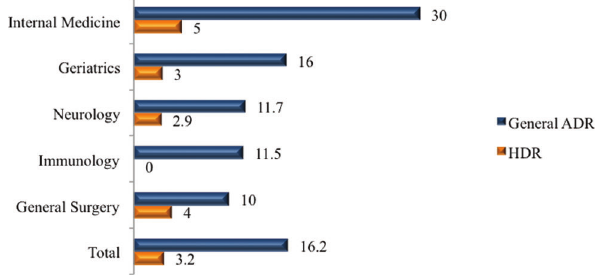
Figure 1 - Incidence of ADRs and HDRs by medical specialty (%). ADR: Adverse drug reaction HDR: Hypersensitivity drug reaction. The ADR rate was higher in Internal Medicine ( p =0.001). Table 1 - Odds ratio of experiencing an ADR by medical specialty, history of previous ADR and number of medications.